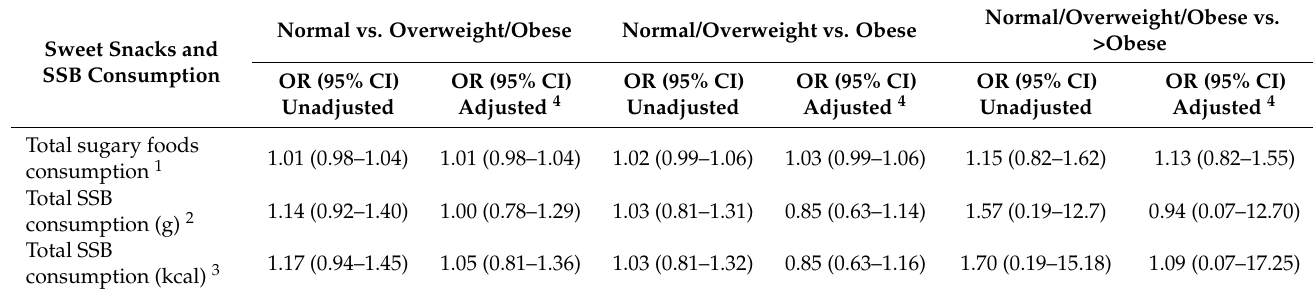
Table 4. Multiple logistic regression results of weight status (BMI-for-age) on sweet snacks and sugar sweetened beverages (SSB) consumption among African American adolescents aged 9–15 in B’More Healthy Community for Kids (BHCK) trial at baseline